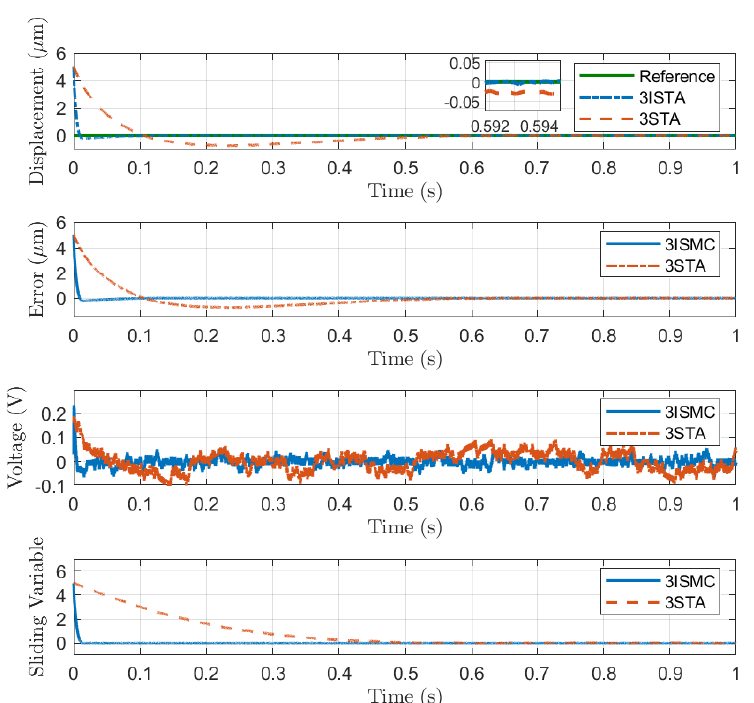
Figure 4. Proposed 3-ISMC control: Time histories of state variables and control inputs corresponding to initial condition of x 0 =[5, 100].